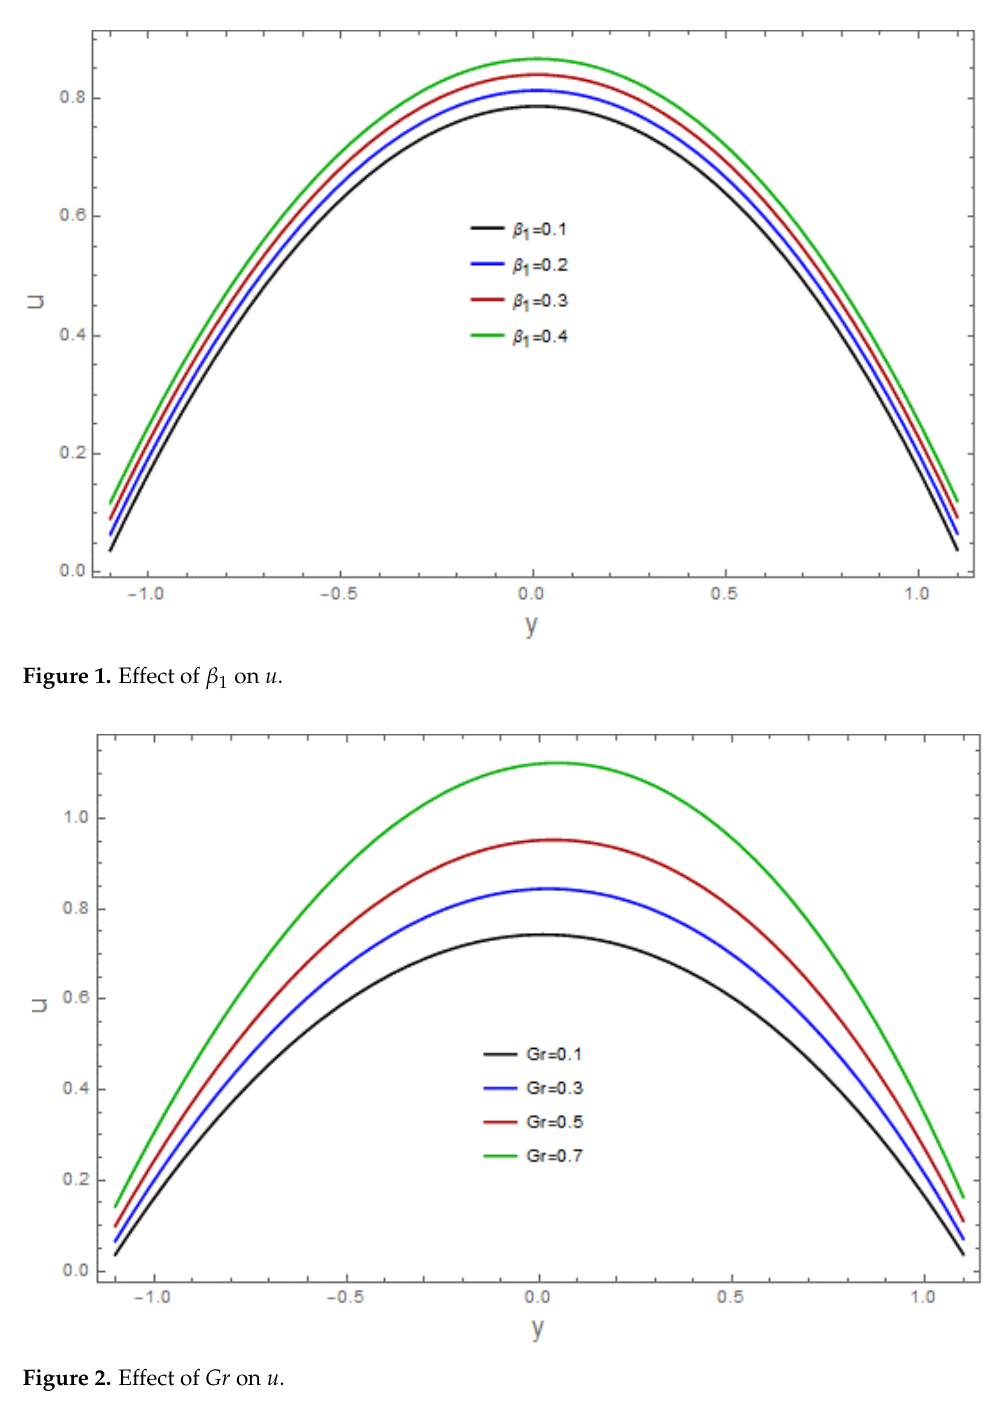
Figure 2. Effect of 𝐺𝑟 on 𝑢 .